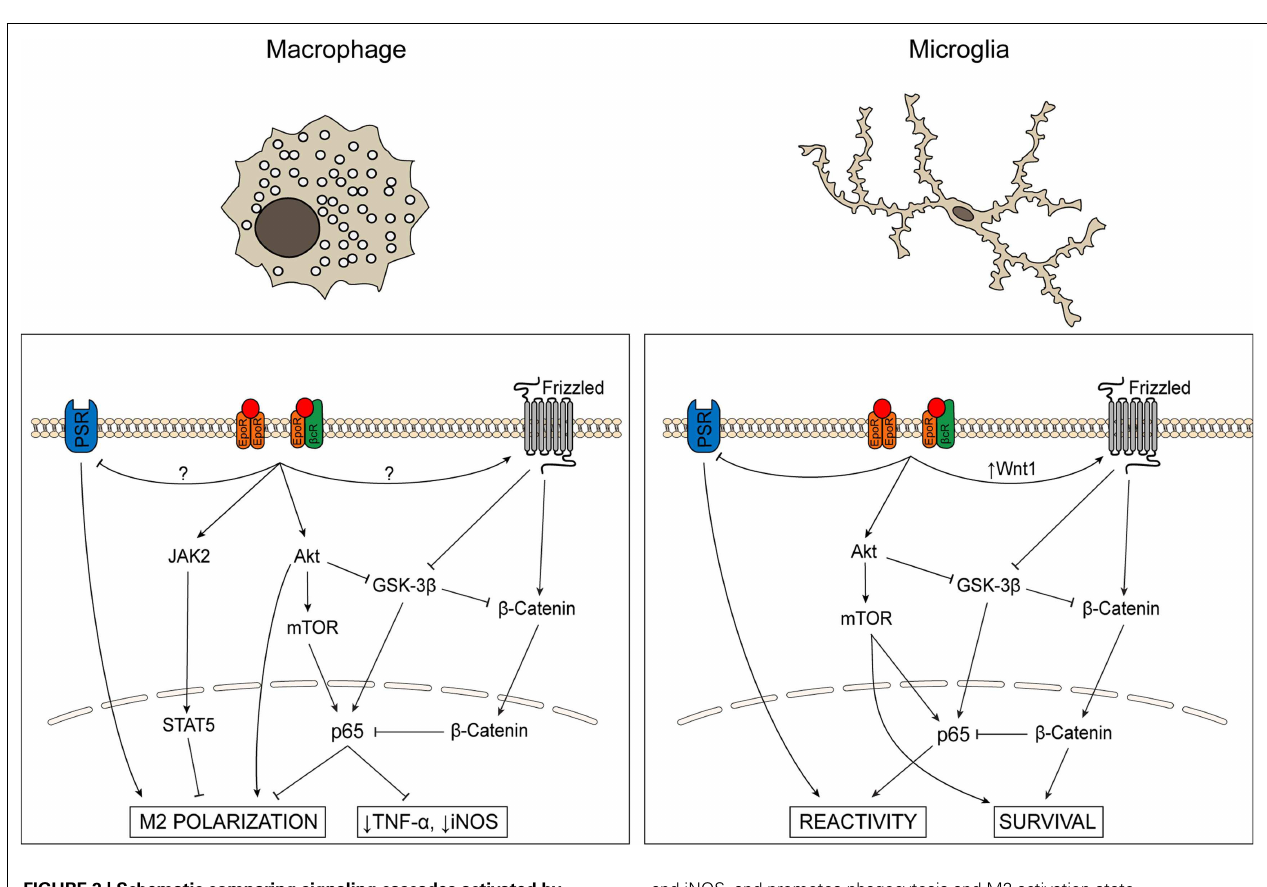
FIGURE 2 | Schematic comparing signaling cascades activated by EPO in microglia and macrophages .The role of EPO in macrophages and microglia has primarily been evaluated in the context of inflammatory state and cell survival, respectively. In macrophages, EPO activates JAK/STAT and Akt signaling, inhibits GSK-3 β activity, modulates NF- κ B p65, decreases levels of pro-inflammatory cytokines